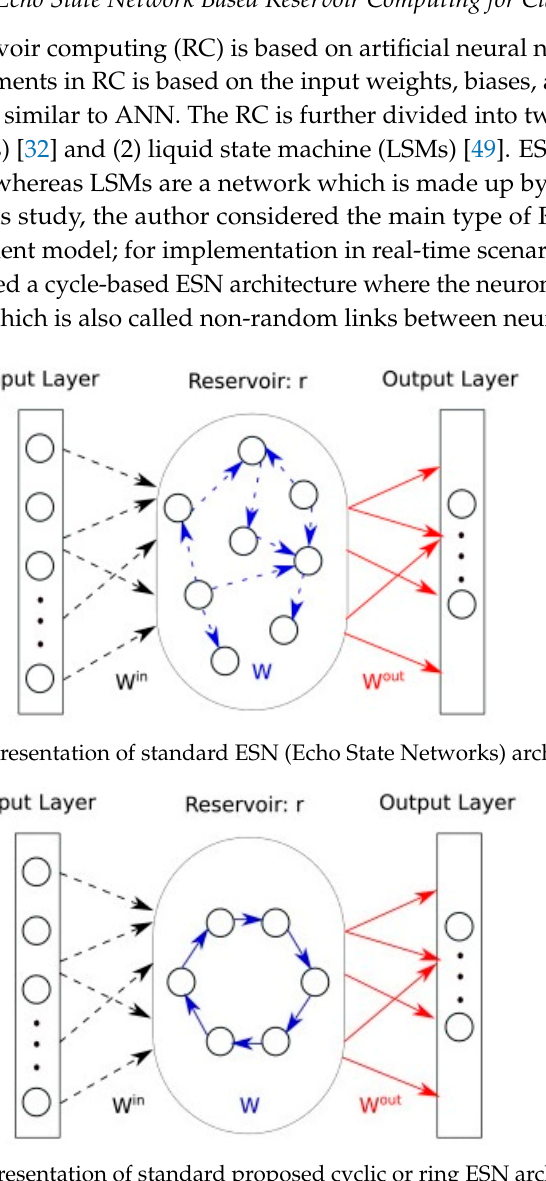
Figure 7. Representation of standard proposed cyclic or ring ESN architecture.